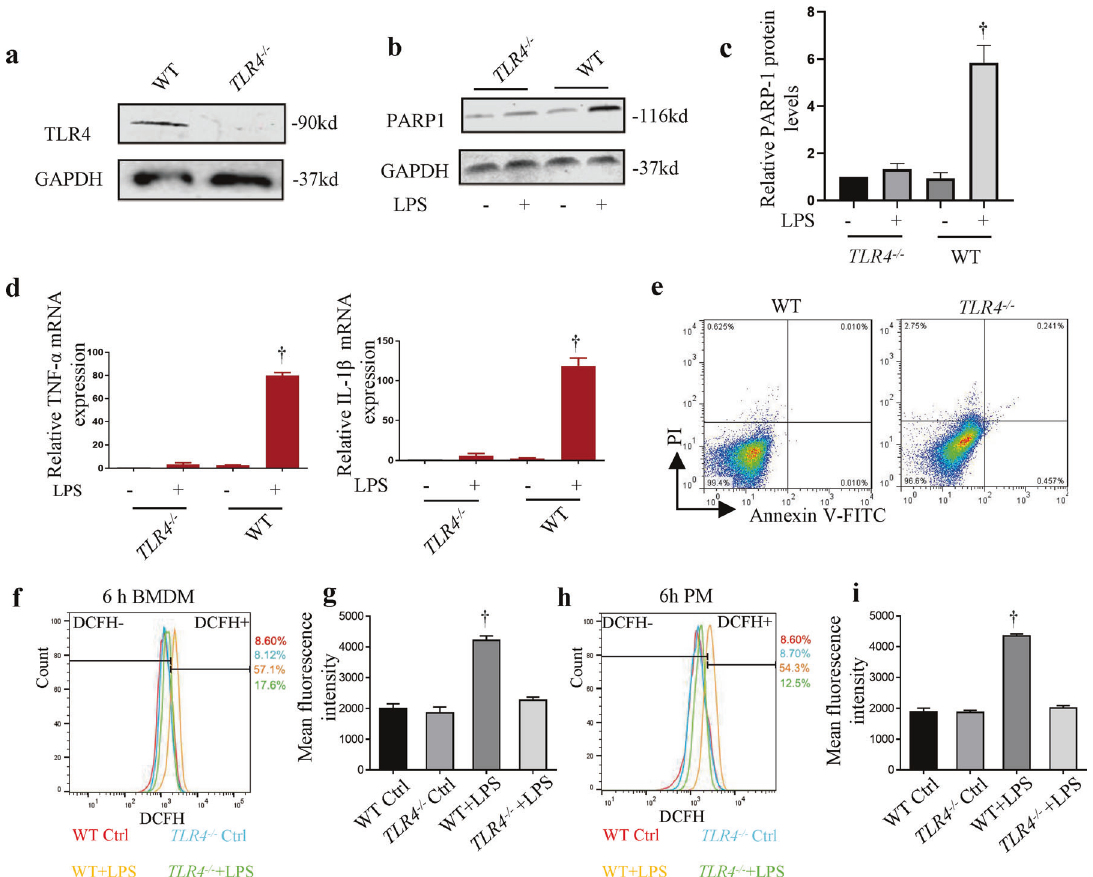
Fig. 5 Downregulated cell surface TLR4 expression inhibits LPS-induced PARP-1 activation. BMDM cells were untreated or primed with LPS (1 μ g ml – 1 ) for 12 h. a Western blot analysis of TLR4 from WT and TLR4 – / – mice BMDM cells. b PARP-1 and GAPDH protein levels. c Mensuration of PARP-1 expressions. d WT and TLR4 – / – BMDM cells were treated with LPS for 6 h following by real-time PCR analysis of TNF- α and IL-1 β mRNA expression. e BMDM cells were treated with LPS for 24 h followed by fl ow cytometry analysis of cell death. f , h ROS production